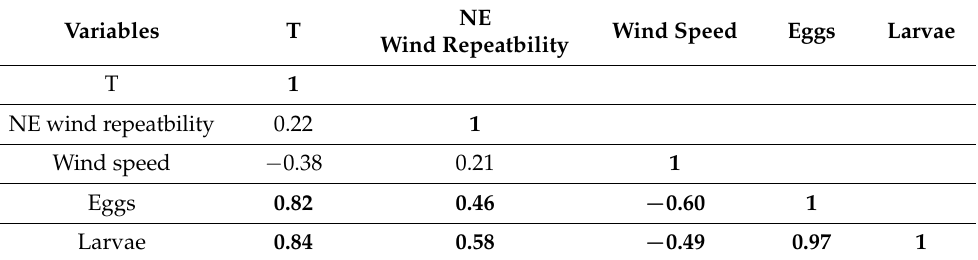
Table 3. Correlation matrix (Pearson (n −